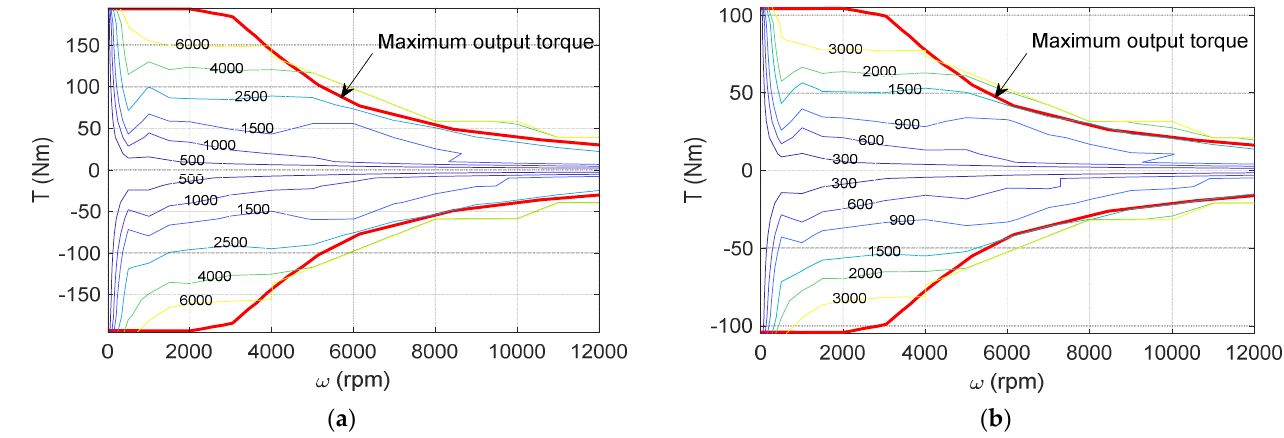
Figure 2. ( a ) Power loss map of EM1, ( b ) Power loss map of EM2.